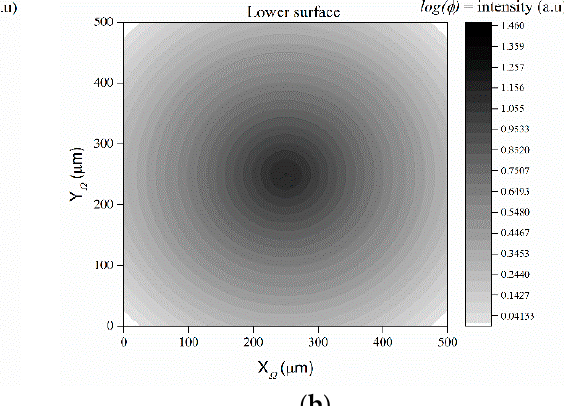
Figure 10. Spatial distribution of Net ROD over ( a ) upper and ( b ) lower surface of EBT3 film after being exposed to 164.70 J/cm 2 UV radiation.